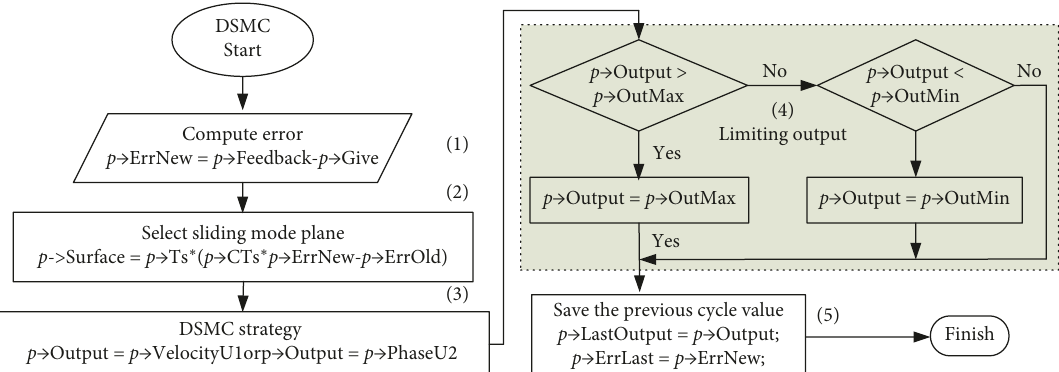
Figure 6: Calculation flow of